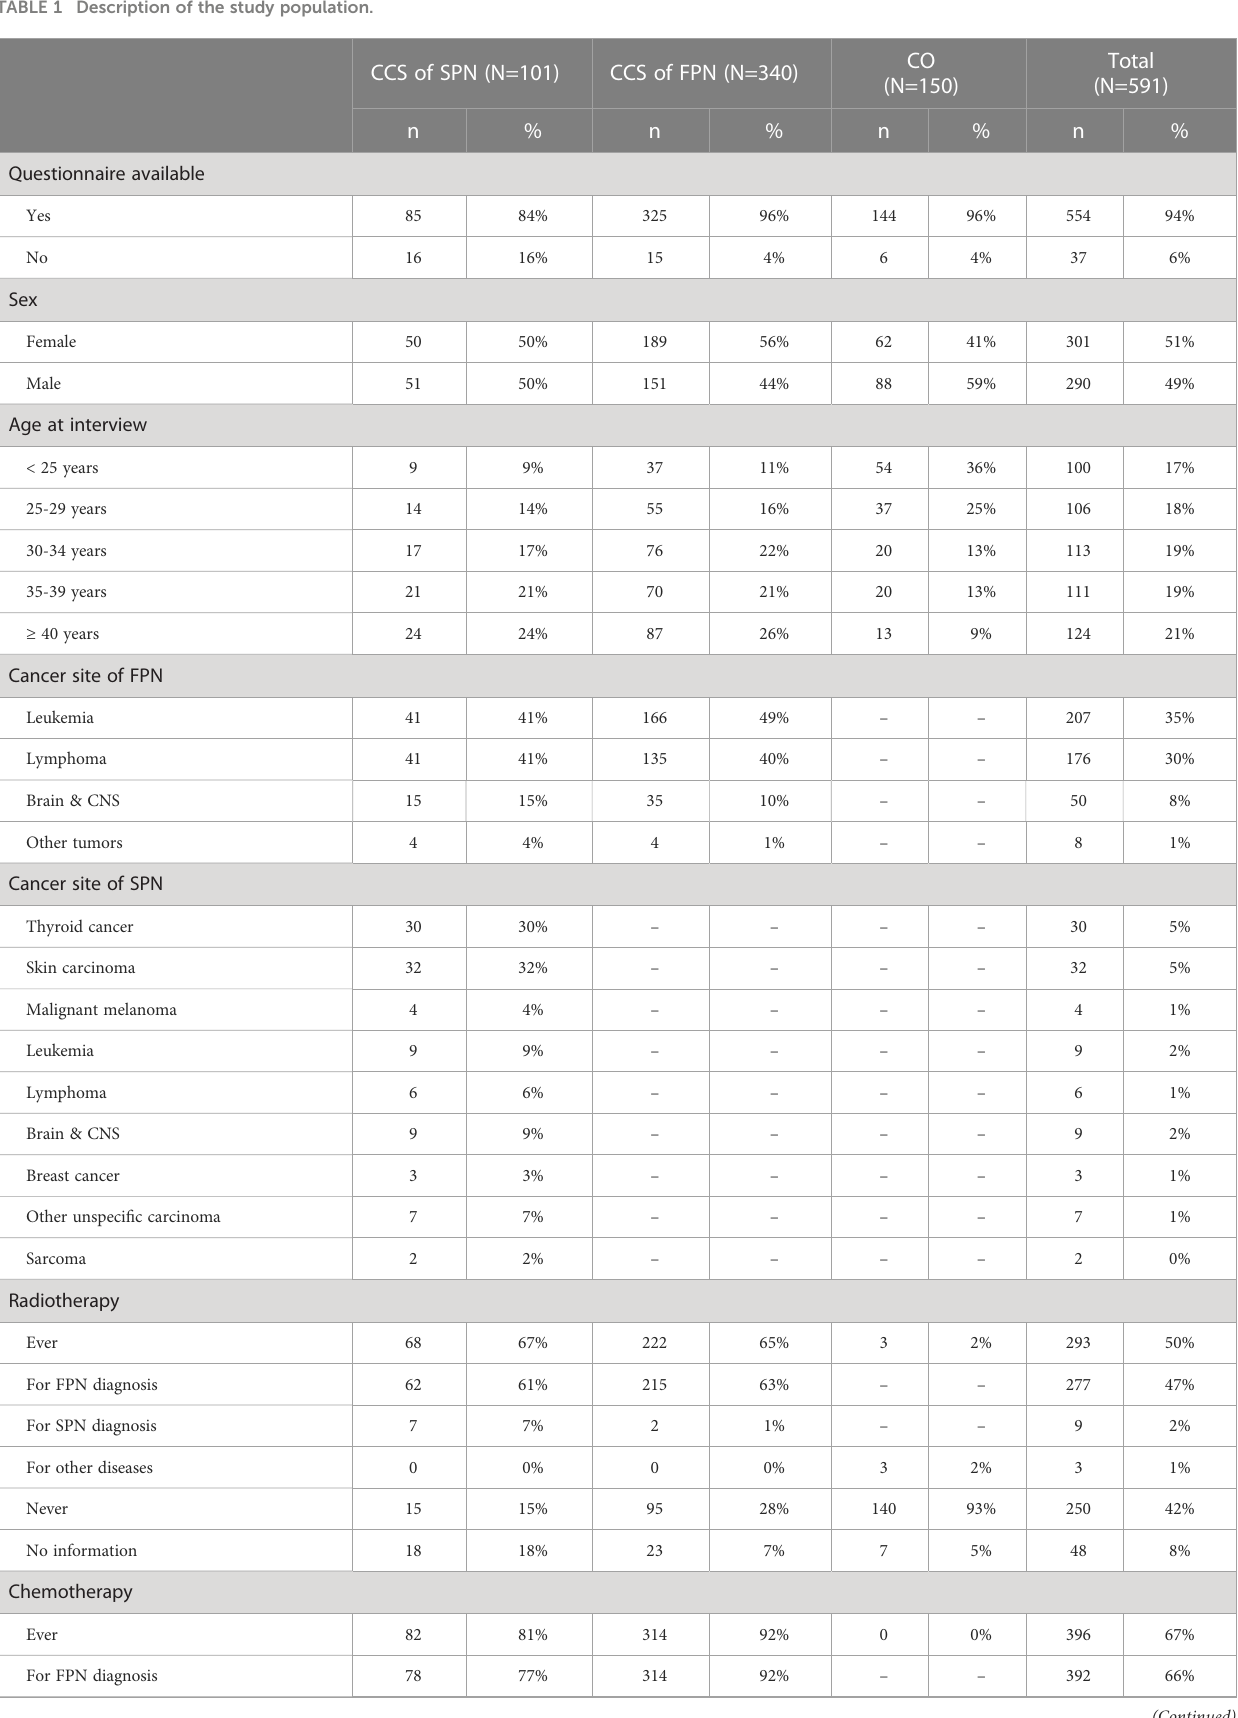
TABLE 1 Description of the study